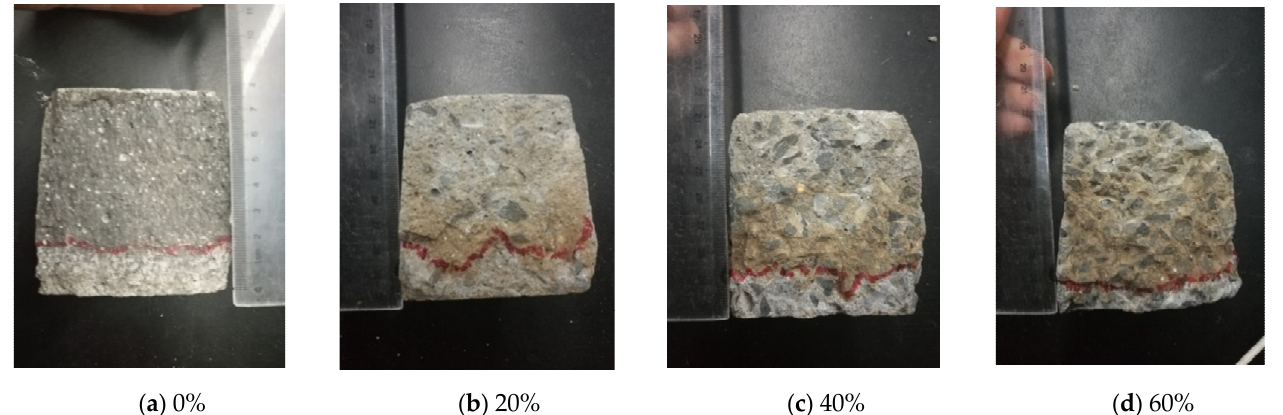
Figure 5. Test results of chloride ion diffusion under different volume fractions of the aggregate under a hydrostatic pressure of 0.5 MPa.